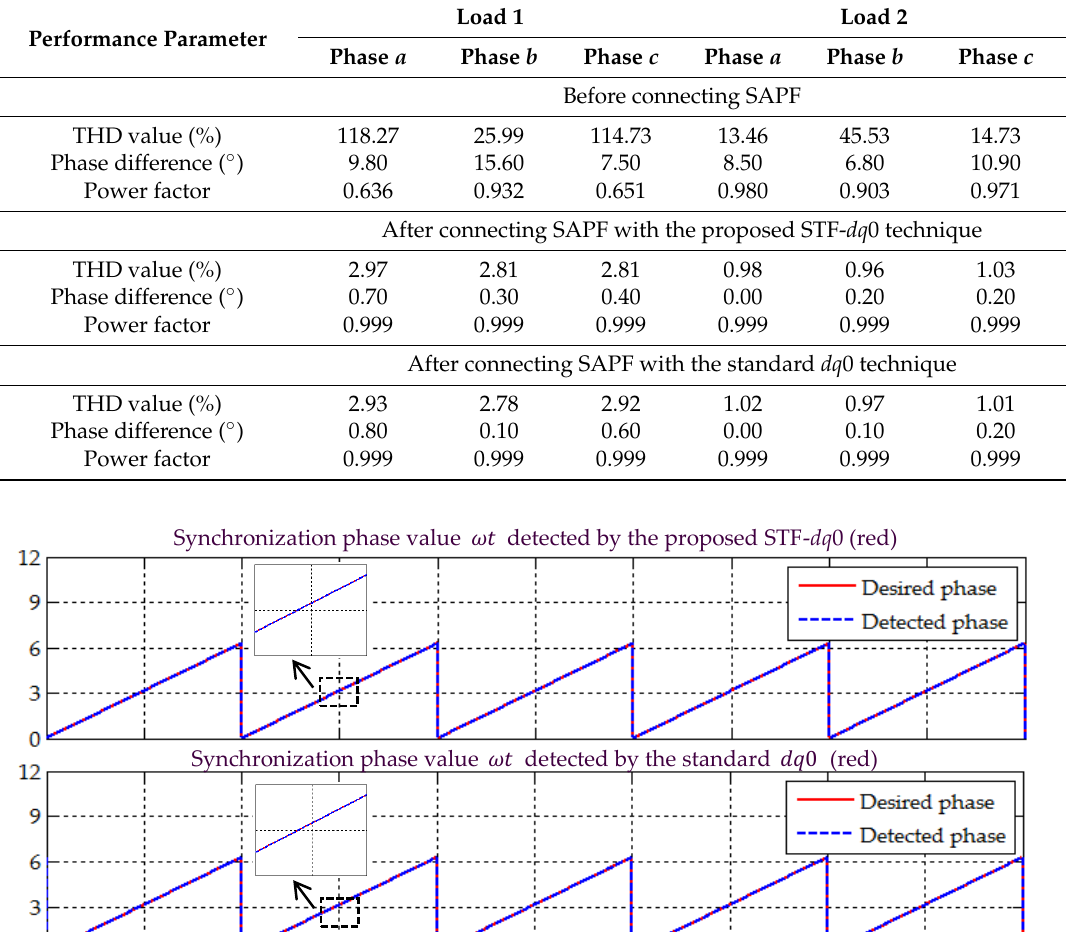
Table 2. Comparative analysis of the proposed STF- dq 0 and the standard dq 0 techniques under Scenario A.